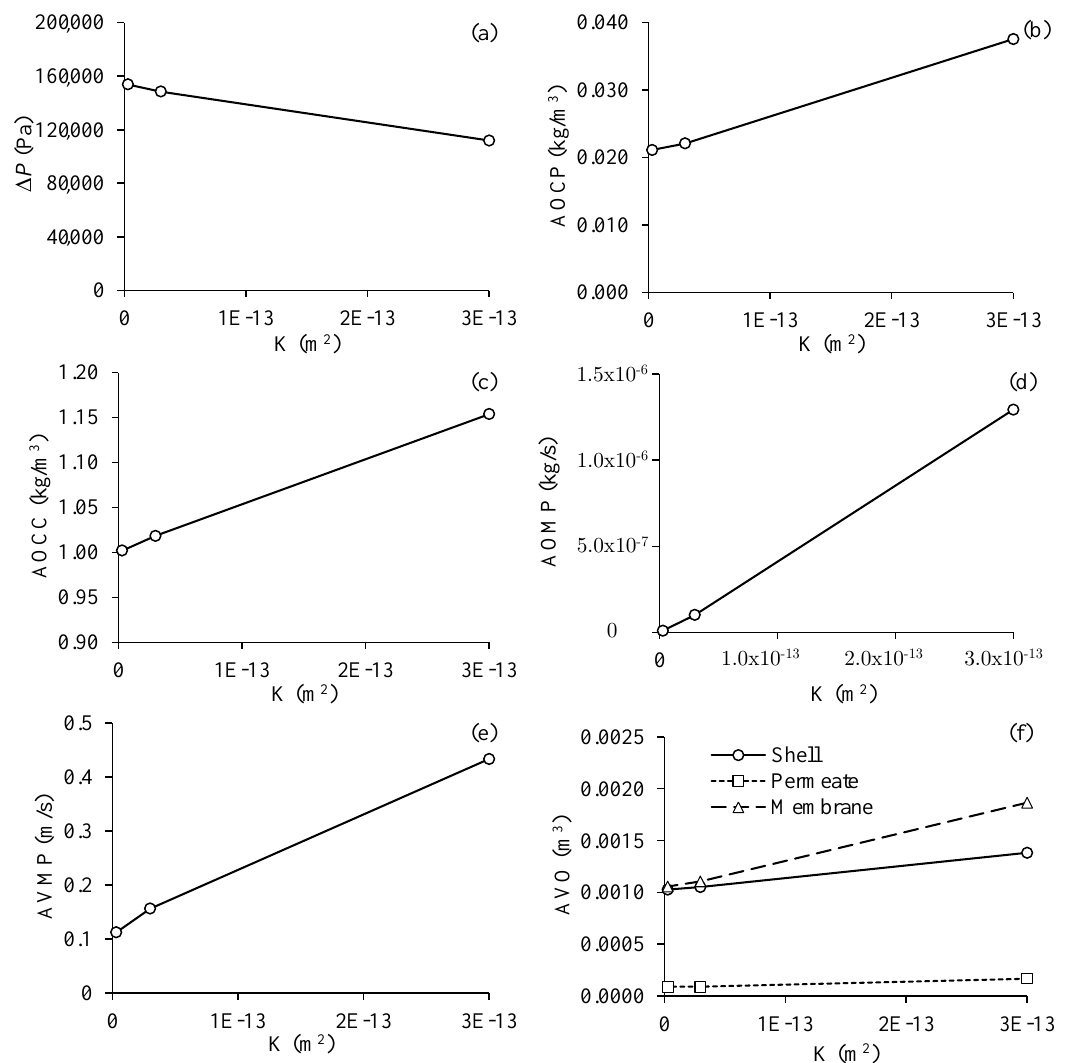
Figure 13. Process parameter in the filtration module as a function of membrane permeability. ( a ) Transmembrane pressure, ( b ) average oil volumetric concentration at the permeate outlets, ( c ) average oil volumetric concentration at the concentrate outlet, ( d ) average oil mass flow rate at the permeate outlets, ( e ) average velocity of the fluid mixture at the permeate outlets and ( f ) average volume of oil present in the hull, membranes and permeate (Cases 5, 10 and 11).